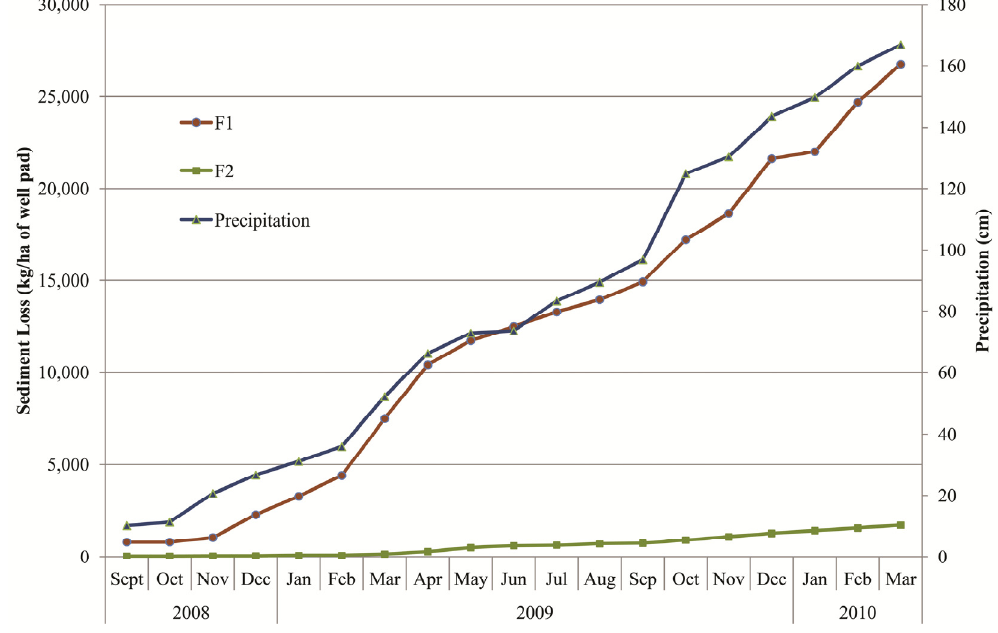
Figure 5. Cumulative sediment yield and rainfall for two natural gas well locations, one placed directly in the stream channel (F1) and the other offset from the channel by a 15 m buffer (F2) at the Alto Experimental Watersheds, Texas,